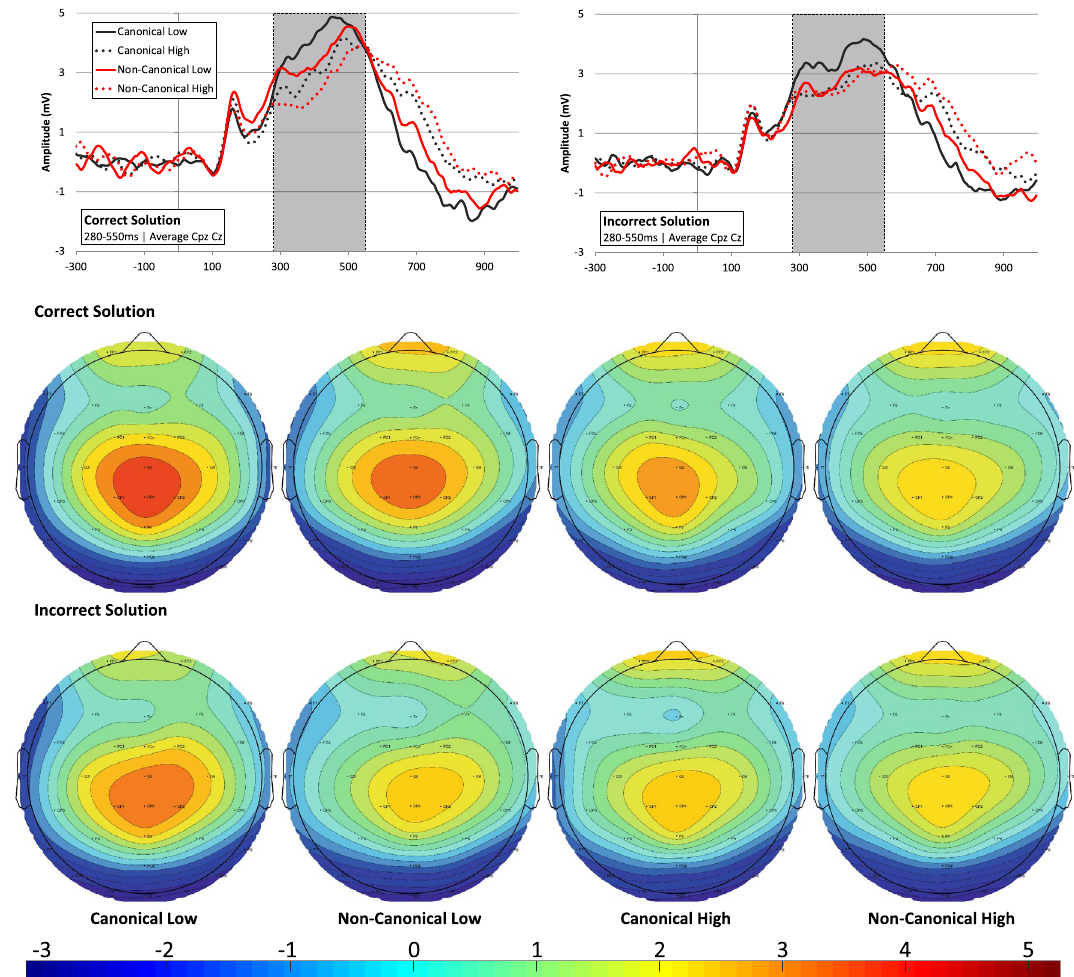
Figure 3. Grand average ERP’s (averaged over CPz and Cz electrodes) with the P3 time window indicated by the grey bar; left and right ERP graphs respectively show the grand average ERPs on correct and incorrect sum solution trials. Topography plots for the 280–550 ms (P3) time-window for correct and incorrect sum solution trials in the four Canonicity-Range categories: Canonical-Low, Non-Canonical-Low, Canonical-High, Non- Canonical-High. The ERP plots show the grand average ERPs and topo-plots in all conditions of the experiment for purposes of evaluation of ERP quality and choice of windows and electrodes for analyses (see: Keil et al. 37 ). For visualization of the specific interaction effects found on P2p and P3 amplitude we refer the reader to Fig. 4B. Images were created by the first author using ERPlab software 38